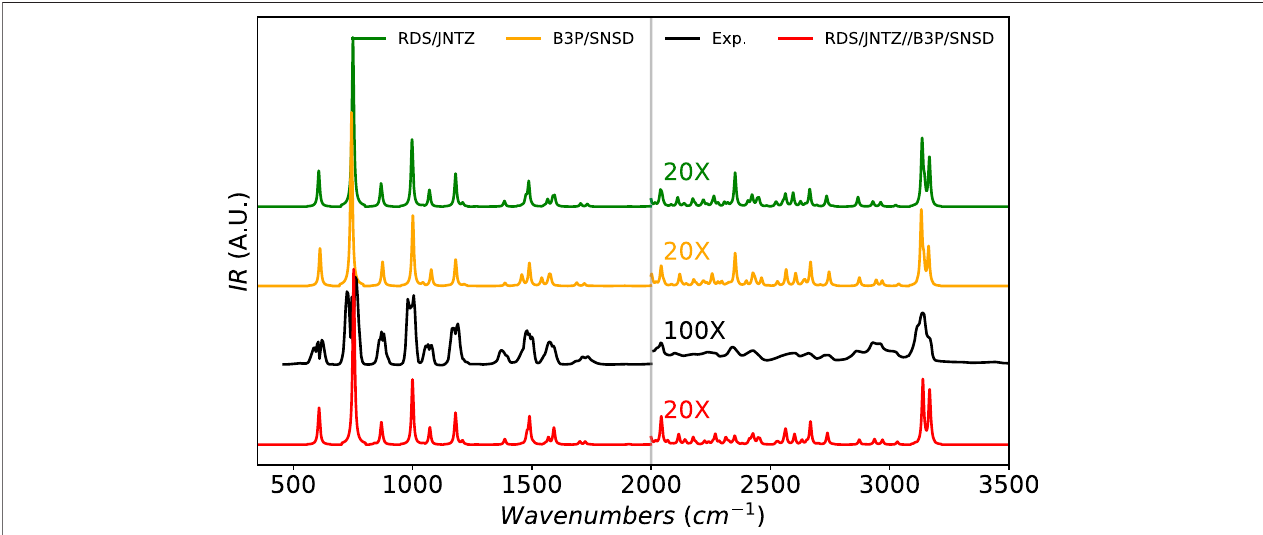
FIGURE 5 | Infrared spectrum of furan at the B3PW91/SNSD ( B3P/SNSD ), revDSD-PBEP86-D3(BJ)/jun-cc-pVTZ ( RDS/JNTZ ) and revDSD-PBEP86-D3(BJ)/ jun-cc-pVTZ//B3PW91/SNSD levels using the GVPT2 scheme, compared to experiment taken from (Mellouki et al., 2001). Theoretical line-shapes were broadened by mean of Lorentzian distribution functions with half-widths at half-maximum of 4 cm − 1 . The region beyond 2000 cm − 1 had been magni fi ed to show the lower-intensity structure. To see more clearly the broader features of the experimental spectrum, a higher magni fi cation was used compared to